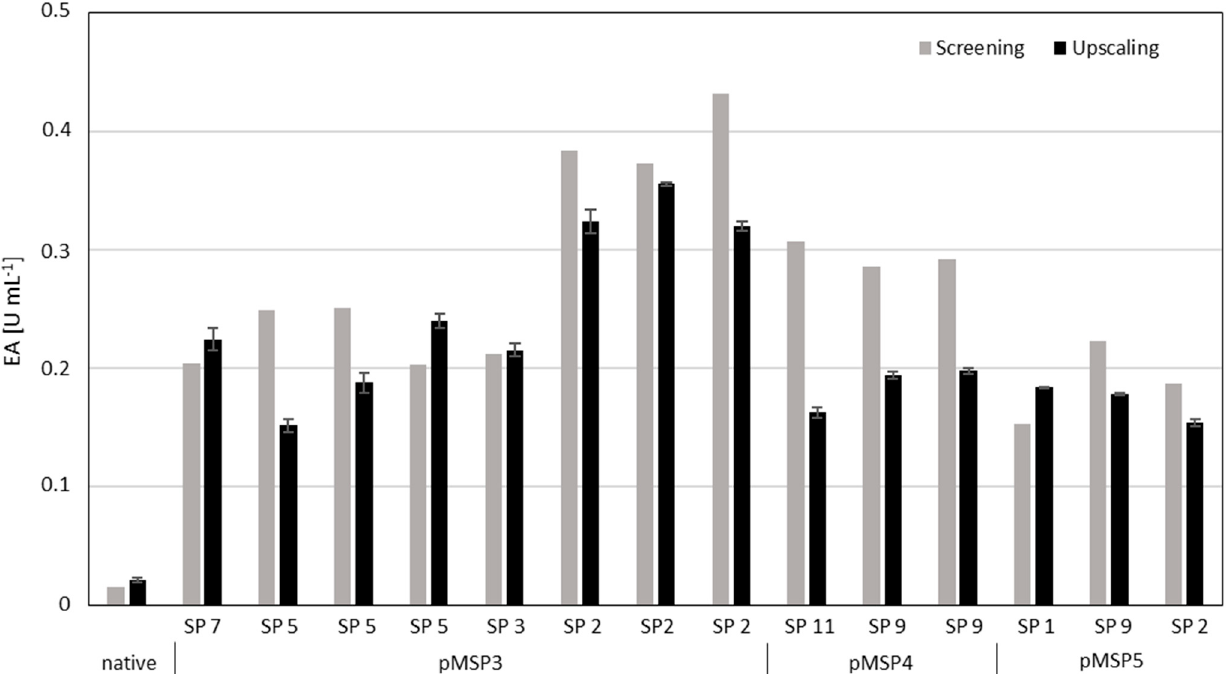
Figure 8. Comparison of volumetric enzyme activity (EA) of selected BmasPGA clones in screening (gray, Figure 6) and upscaling (black). The clones with the native SP as control and the new SPs were cultured at 37 °C in shake flasks (50 mL culture volume). Twenty-two hours after induction of recombinant PGA secretion, the PGA activity was determined in cell-free supernatant by NIPAB assay in triplicates at 37 °C. pMSP3 to 5 are indicating the corresponding multi-SP plasmids; SP X indicates the corresponding SP of the given plasmid as presented in Table 2. Table 3. Signal peptides achieving a better secretion of BmasPGA compared to the native